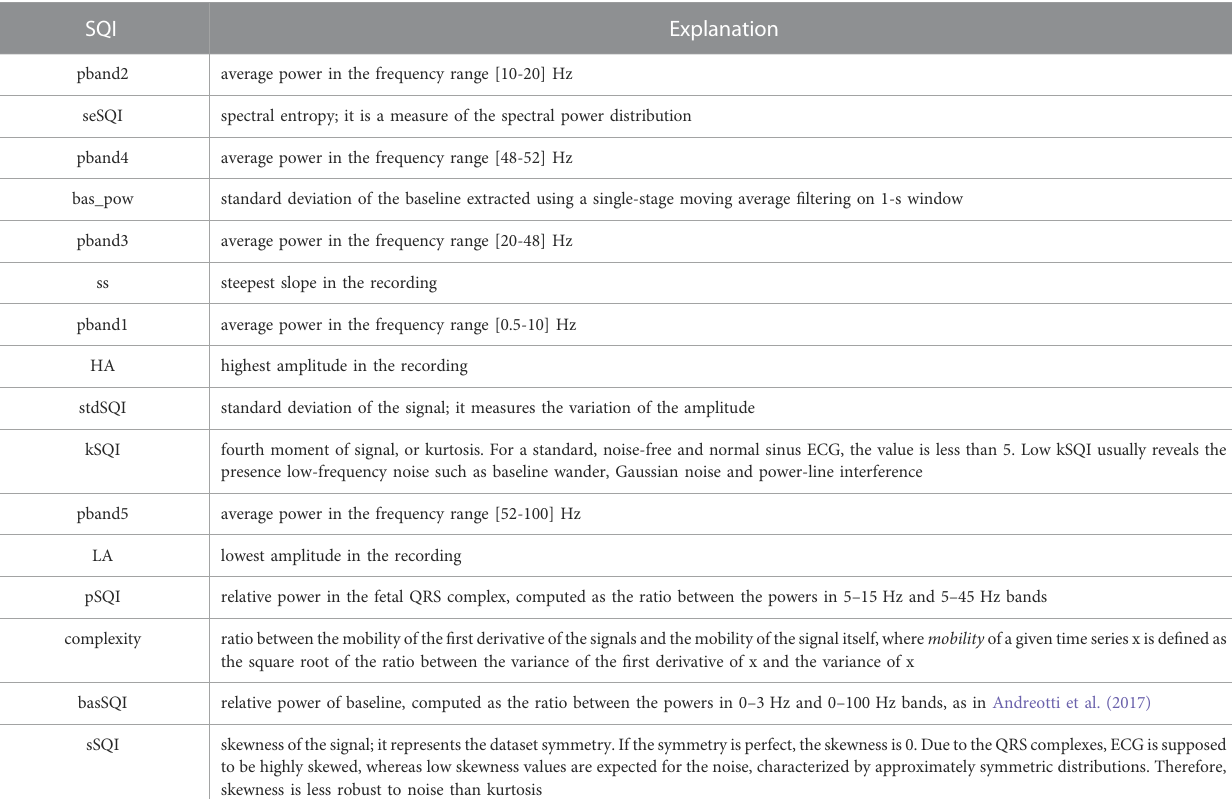
TABLE 1 List of all features extracted from the 5-s long abdominal ECG segments, ranked according to the mRMR-based relevance score. SQI Explanation